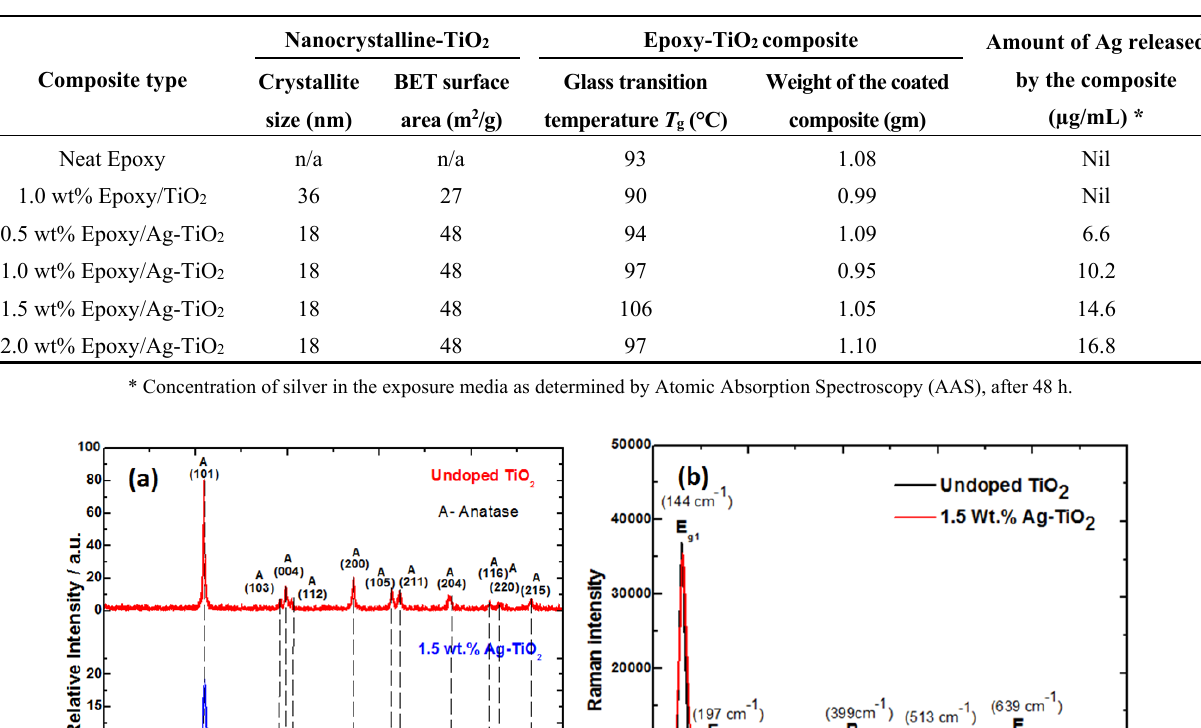
Table 1. Physio-chemical properties of nanofiller, T g , weight of coated composite material and amount of silver ion released.